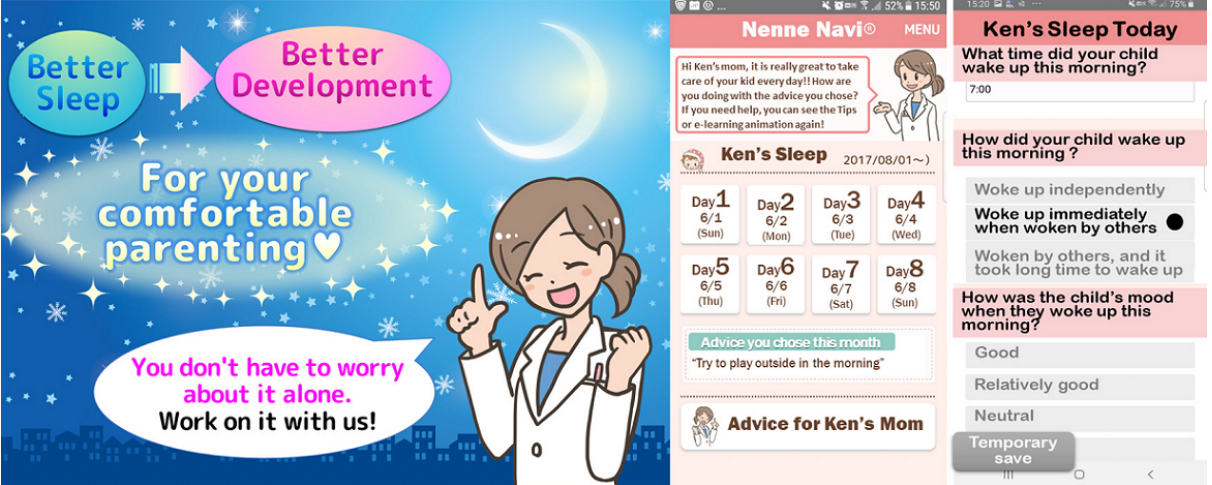
Figure 1. Nenne Navi screenshots, including the page used to enter lifestyle information and provide users with messages and advice from pediatric sleep experts and the page for data